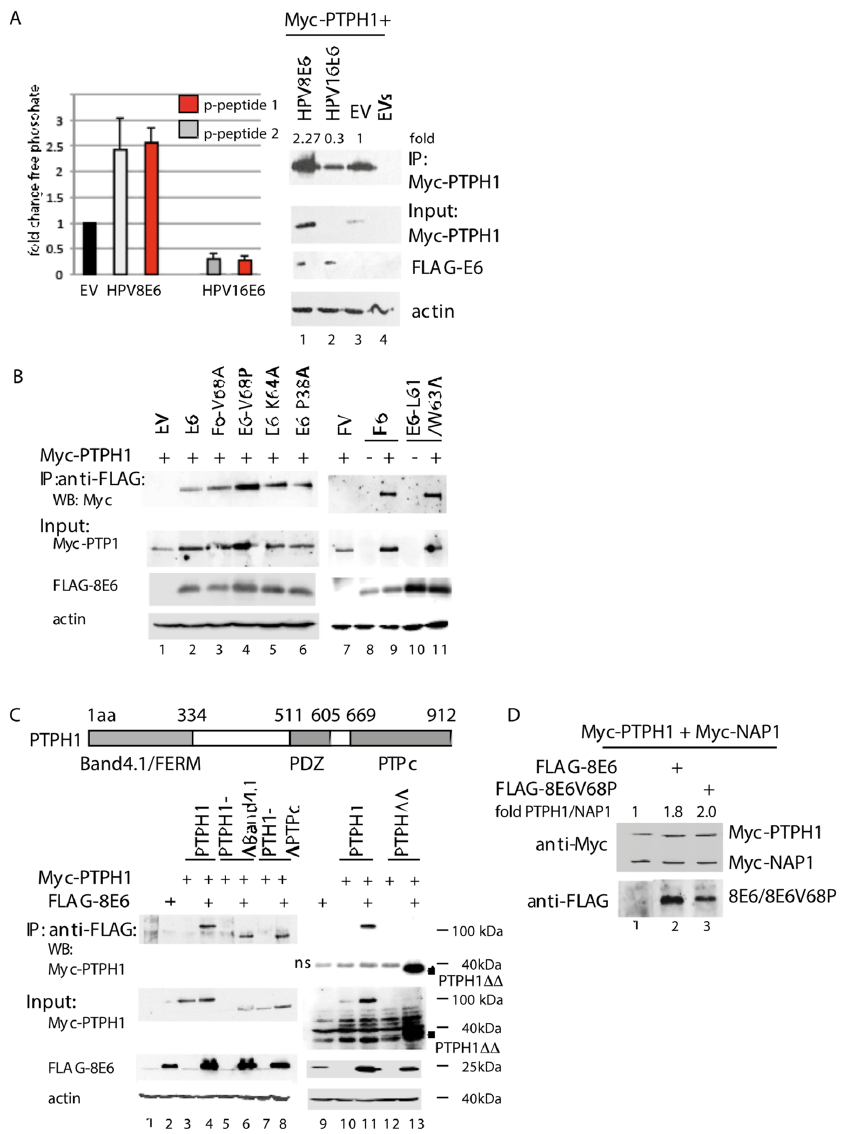
Figure 2. Increased level of PTPH1 in the presence of HPV8E6. ( A ) C33A cells were transfected with expression vectors for Myc-PTPH1 and pcDNA-FLAG empty vector (EV), pcDNA-FLAG-8E6 or pcDNA-FLAG-16E6. The precipitated Myc-PTPH1 was used in a Malachite Green PTP assay according to the manufacturer’s instruction. The values obtained for Myc-PTPH1 without co-expression of an E6 protein was set as 1 and those upon co-expression of E6 of HPV16 and HPV8 have been calculated. The graph represents the results from 3 independent assays. The WB shows the amount of precipitated Myc-PTPH1 which was used for one representative PTP assay, and that in the input, including the FLAG-E6 proteins. The signals were quantified by Image J. ( B and C ) C33A cells were co-transfected with expression vector for wt Myc-PTPH1 or deletion mutants and pXJ41-FLAG-HPV8E6 wt or point mutants as indicated in the figure. Extracts were incubated with FLAG beads and co-precipitated Myc-PTPH1 was detected by WB. The input was analyzed for Myc-PTPH1 and FLAG-HPV8E6. Actin served as loading control. * indicates the presence of Myc-PTPH1 ΔΔ (aa334-669) in the input. In ( C ) an overview of the structure of PTPH1 is given with the localization of the Band4.1/FERM, the PDZ and the C-terminal catalytic PTPc domain. The numbers above refer to the positions of the amino acids (aa). ( D ) Extracts from C33A cells transiently co-transfected with CMV-driven expression vectors for Myc-PTPH1 or Myc-NAP-1 and FLAGHPV8E6 or E6V68P were used for WB to detect the proteins as